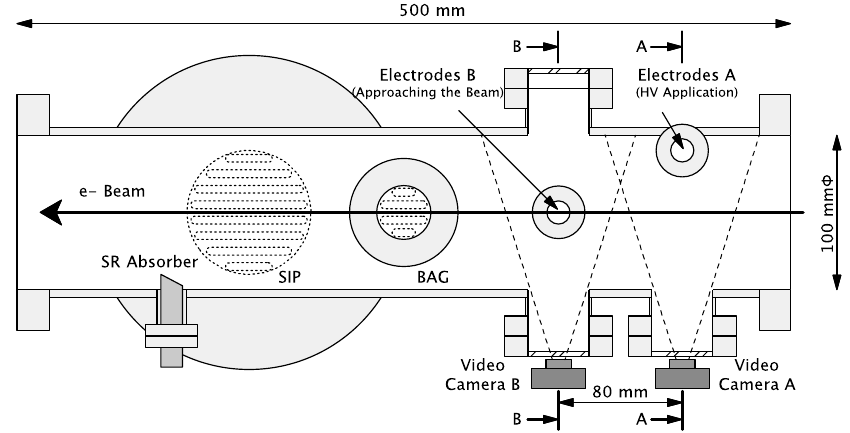
fields.FIG. 2. Schematic representation of the discharge device